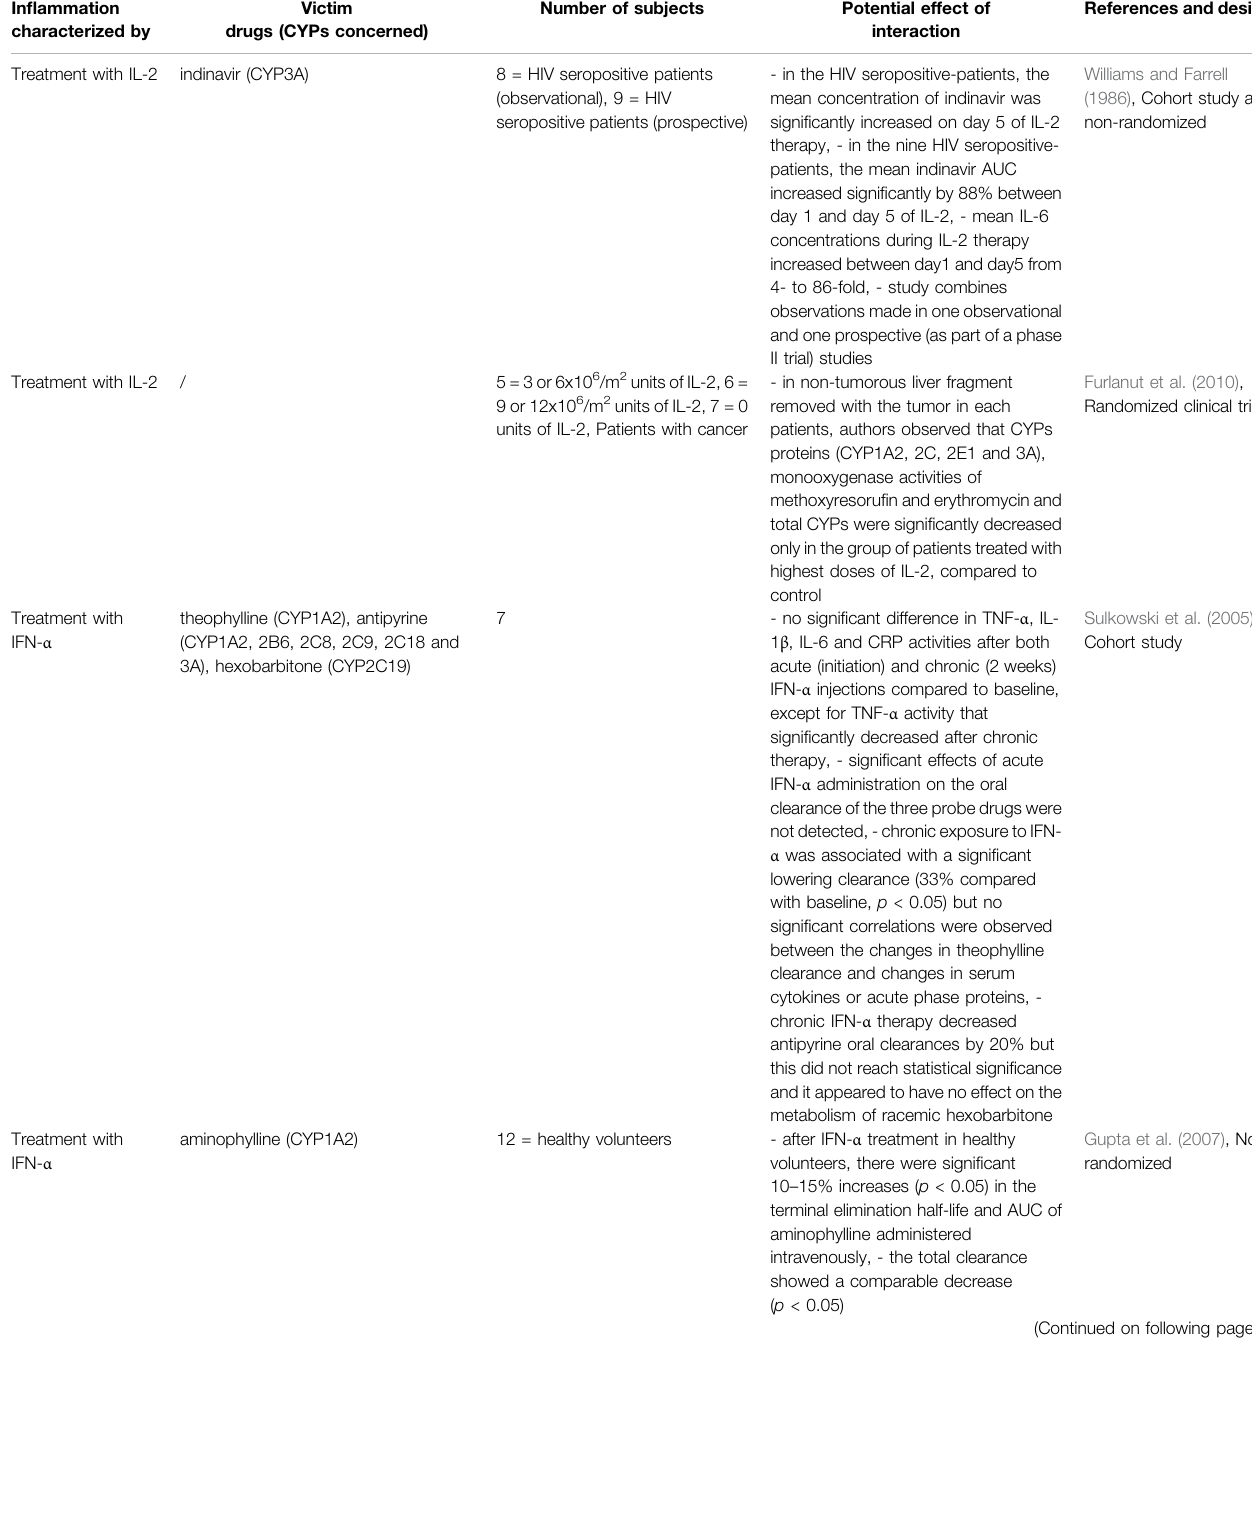
TABLE 13 | Impact of therapies with immunomodulator on CYP substrates, explained totally or partially by modulation of CYP activity. In fl ammation characterized